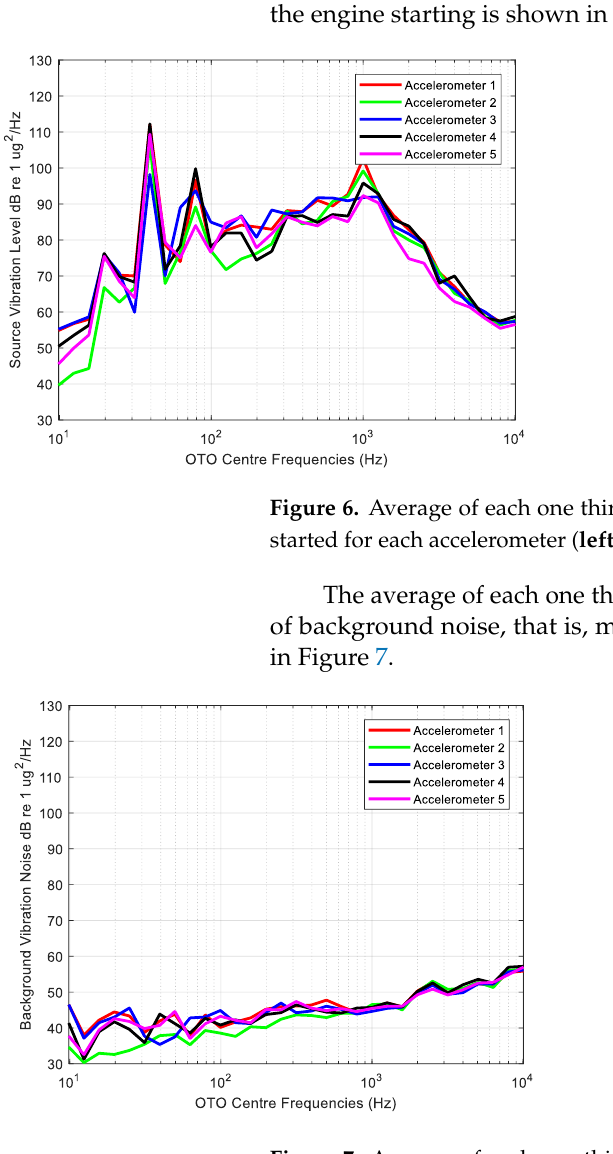
Figure 8. Signal to Noise Ratio ( 𝑆𝑁𝑅 𝑑𝐵 ) computed for the average of each one third octave band of vibration ( left ) and acoustic ( right ) measurements. The lowest acoustic and vibration levels are observed in very low and high frequen- cies, whereas the highest levels can be observed in frequency bands with centre frequen- cies of 40, 80 and 1000 Hz. Variability in acceleration levels across frequency is lower than that of acoustic measurements, in which the lowest levels are provided by the hydrophone deployed at the bow. Analysed frequencies range from 10 Hz to 10 kHz, the 𝑆𝑁𝑅 𝑑𝐵 being higher than 0 dB for all OTO bands. According to the average levels of the acoustic background noise shown in Figure 7, the hydrophone 3 levels at these bands are the highest measured dur- ing the experiment, meaning that the lower 𝑆𝑁𝑅 𝑑𝐵 is due to the existing background lev- els at this measurement point. The analysis of the source strength concludes that the levels of the measurements using the main engine as source of vibration could be useful to estimate the underwater radiated noise from hull vibrations. Specifically, according to the results of the 𝑆𝑁𝑅 𝑑𝐵 analysis in this research, the main engine can be used to excite the hull’s panels.